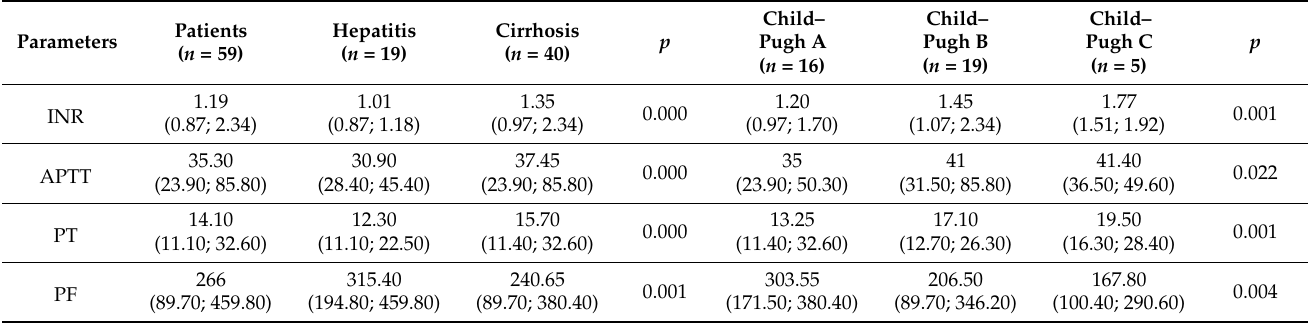
Table 2. Conventional coagulation factors.